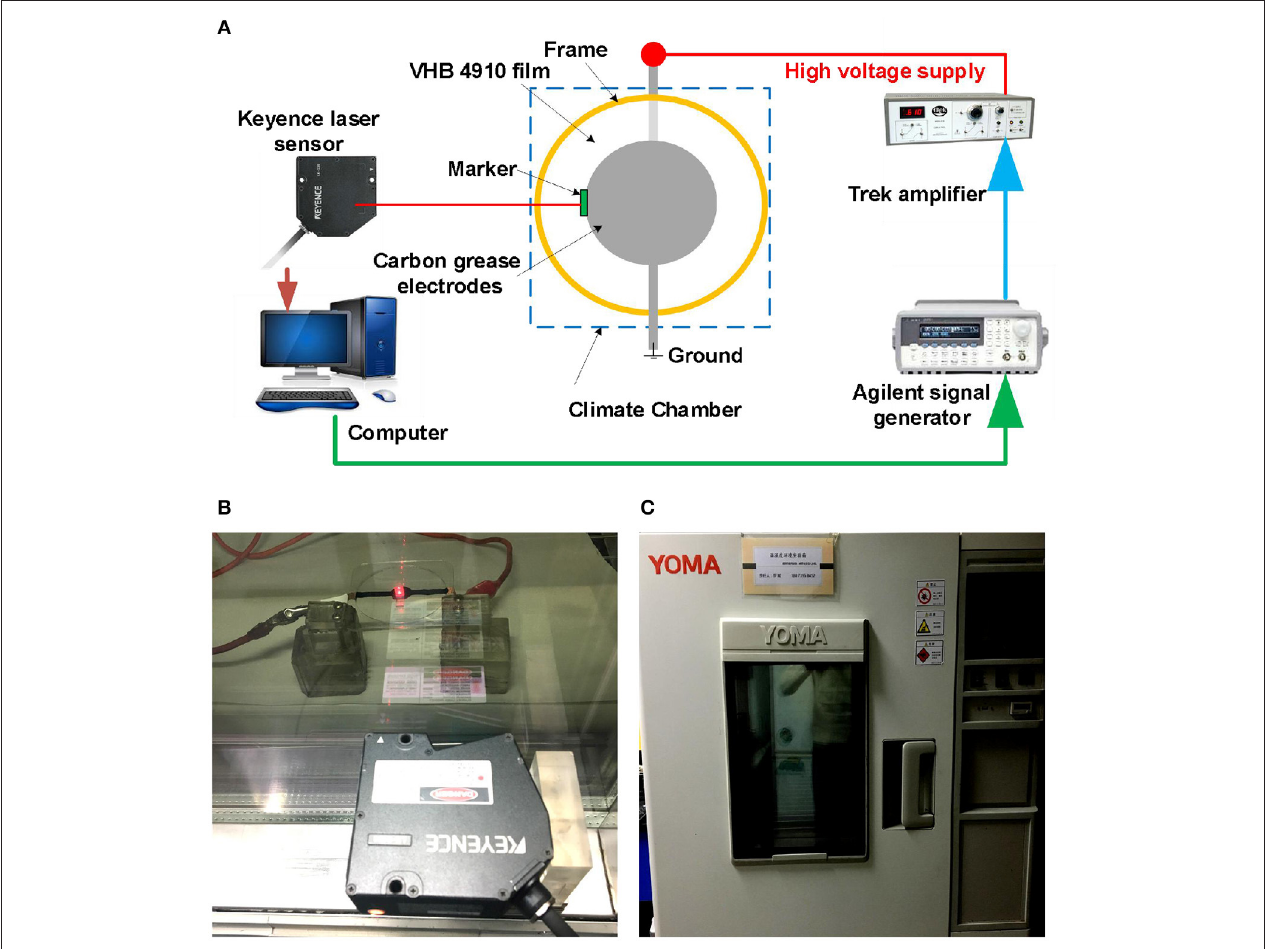
FIGURE 1 | Experimental setup for dynamic breakdown tests of DEAs. (A) The schematic diagram of the experimental platform. ( B) Photograph of a DEA under dynamic voltage excitation. (C) The climate chamber with constant humidity and